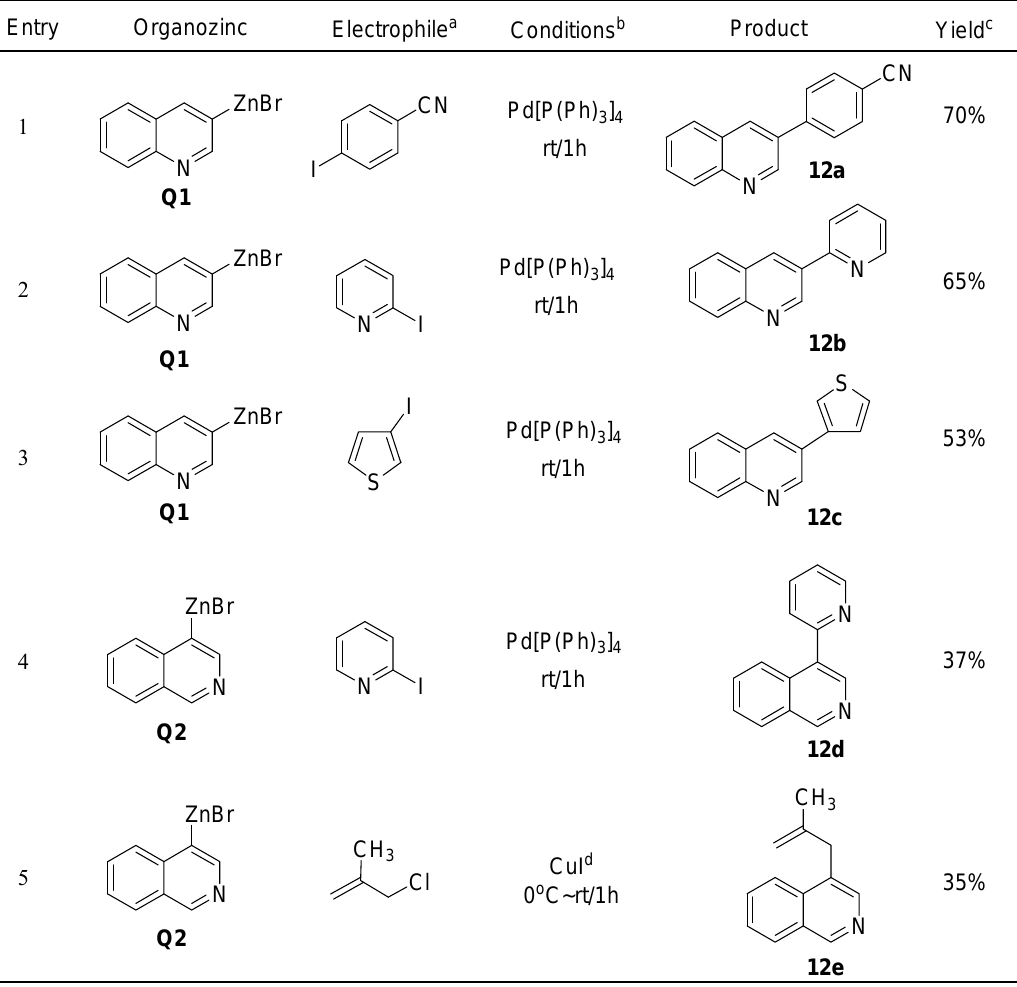
Table 12. Preparation of quinoline and isoquinoline derivatives via heteroarylzinc